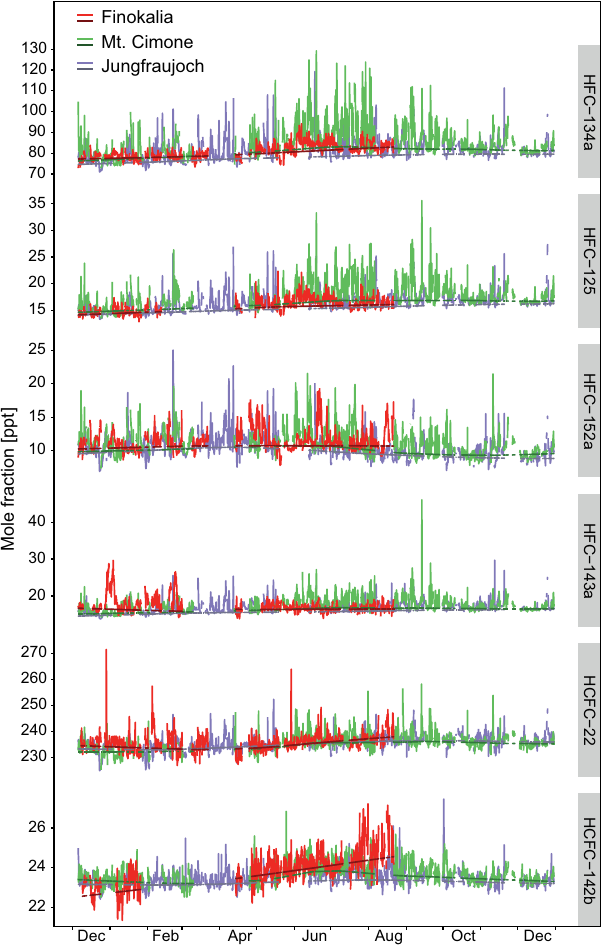
Figure 3. Halocarbon observations in 2013, during the time of the measurement campaign in Finokalia (red) and simultaneous mea- surements at Jungfraujoch (purple) and Monte Cimone (green). The corresponding background estimated with REBS is shown in the darker shade of the respective color (ppt refers to Supplement unit pmolmol − 1 )